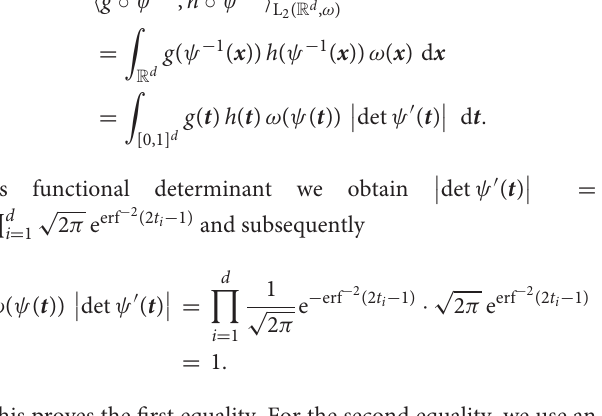
FIGURE 3 | Transformed basis functions φ trafo k for k and k 3 (dashed), in one =